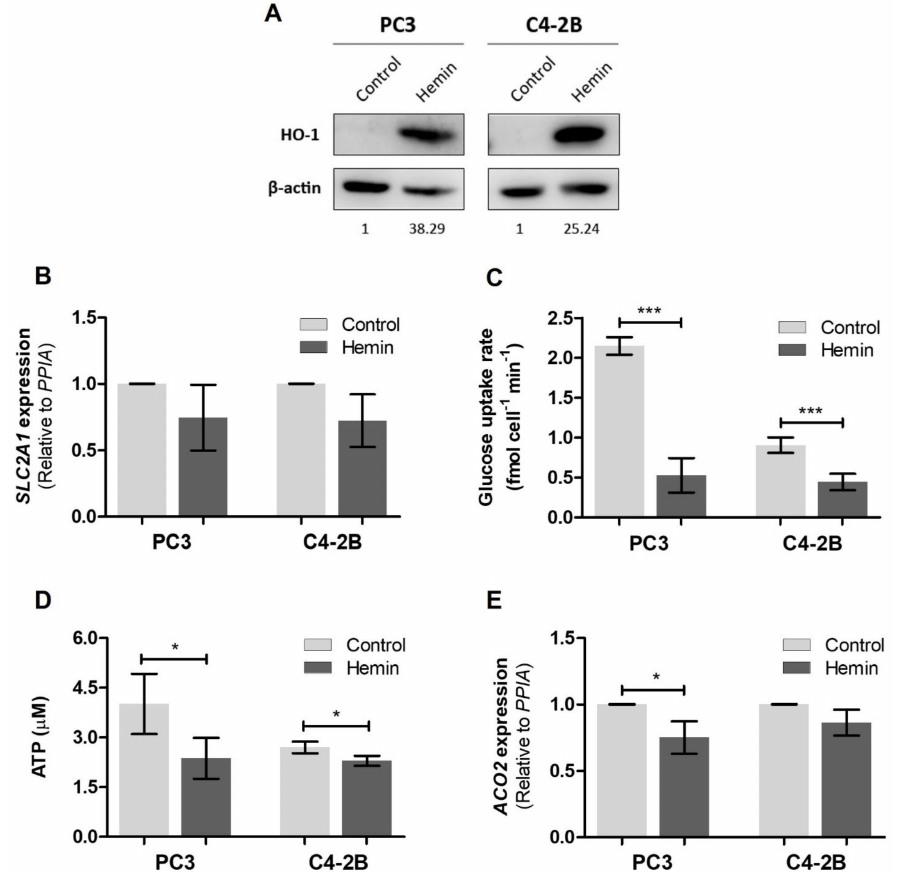
Figure 1. Effect of HO-1 pharmacological induction on the metabolism of PCa cells. ( A ) Western Blot analysis for HO-1 and β -actin in control and hemin treated (80 µ M, 24 h) PC3 and C4-2B cells. Protein quantification, normalized to β -actin (loading reference) and to control lane, is indicated under each band. One representative of three independent experiments is shown. ( B ) SLC2A1 (GLUT1) mRNA expression in PC3 and C4-2B cells under HO-1 induction assessed by RT-qPCR. Values were relativized using PPIA as the reference gene and normalized to the control. ( C ) Glucose uptake rate after hemin treatment in PC3 and C4-2B cell lines, determined using the Glucose Uptake-Glo Assay (Promega, USA). ( D ) ATP production in hemin treated PC3 and C4-2B cells, measured with the CellTiter-Glo Luminescent Cell Viability Assay (Promega, USA). ( E ) ACO2 mRNA expression in PC3 and C4-2B cells under hemin treatment, assessed by RT-qPCR. Values were relativized using PPIA as reference gene and normalized to the control. ( B – E ): Data are presented as mean ± SD of three independent experiments, each performed in triplicate. Significant differences: * p < 0.05; *** p <